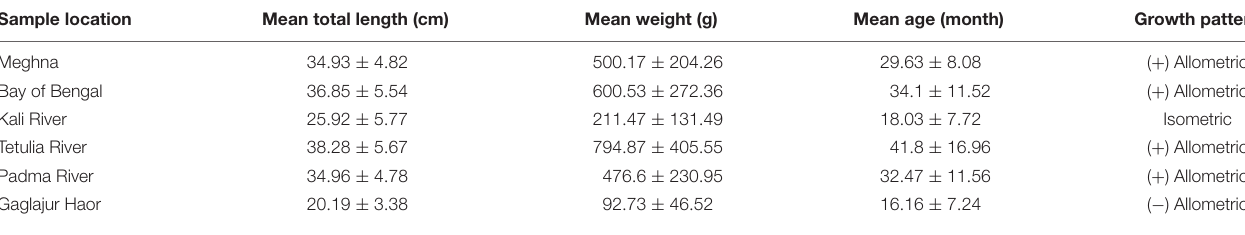
TABLE 1 | Age and growth parameter of Hilsa sample collected from six different habitats. Sample